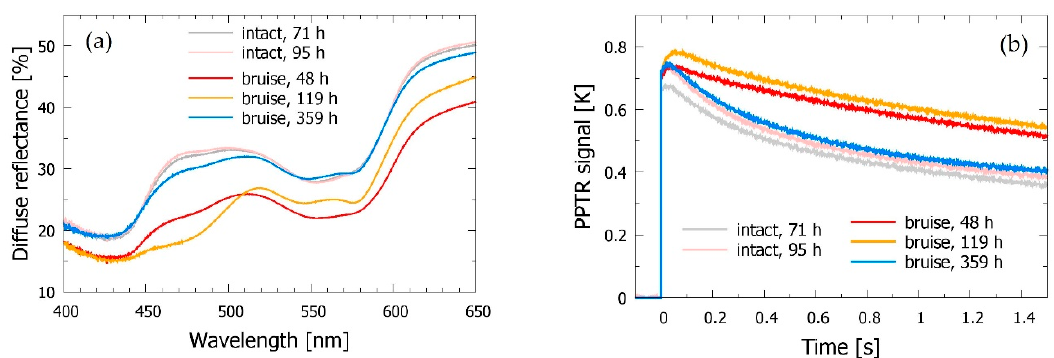
Figure 3. ( a ) DRS spectra and ( b ) PPTR signals obtained from the intact (gray and pink lines) vs. bruised skin site in subject a at different times after the injury (see the legends).